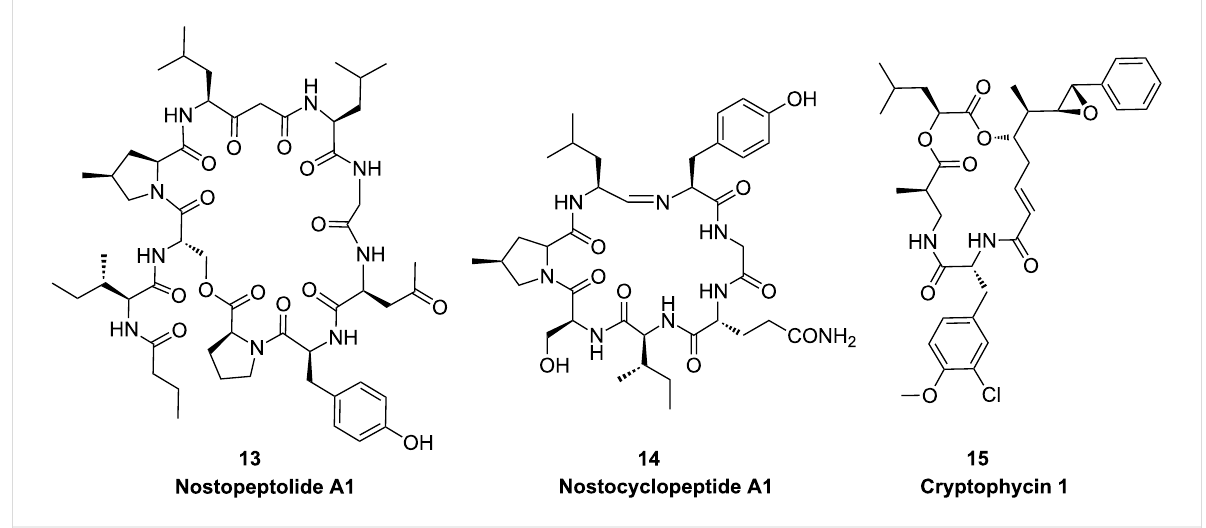
Figure 7: Structures of NRPS and PKS products in terrestrial cyanobacteria.